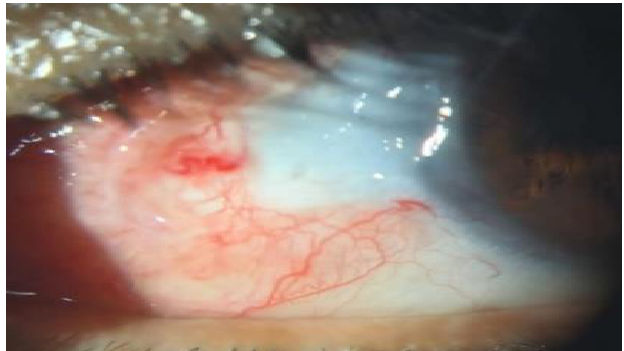
Fig. 2. Uveal show disappeared after intensive treatment.